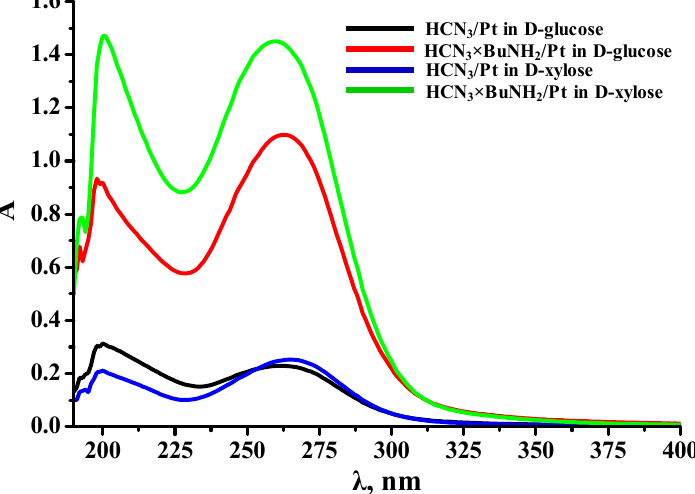
Figure 5. Ultraviolet absorption spectra of the reaction solutions after photocatalytic experiments (5× dilution; solid samples were separated via centrifugation).